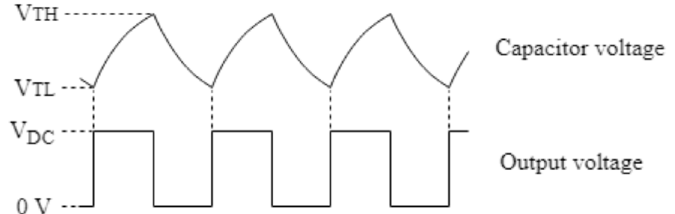
Figure 8. Waveforms at the non-inverting input and at the output of the comparator.